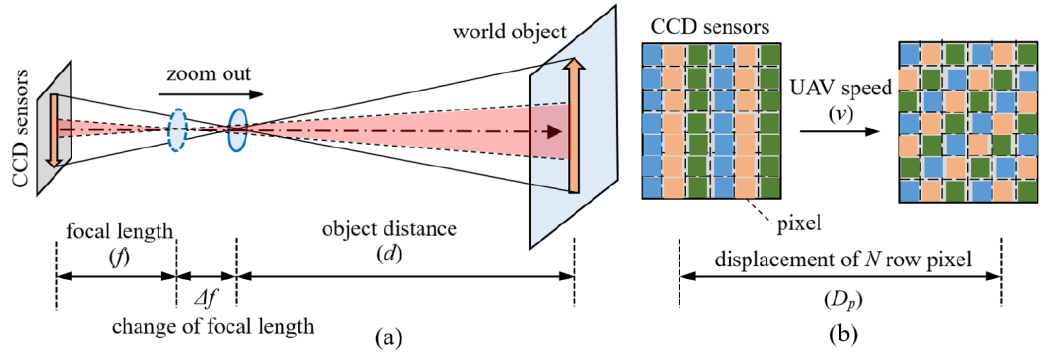
Figure 3. Zoom camera model ( a ) and motion blur principle ( b ). The degraded image g ( x , y ) caused by camera movement and noise during UAS-based imaging can be considered as the convolution of the interference-free image f ( x , y ) and the point spread function p ( x , y ) plus the environment noise n ( x , y ) , expressed as: where x and y represent the horizontal and vertical coordinates of pixels in the image coordinate system. For an image with size [M , N] , the pixel in it can be expressed as (cid:1) (cid:0) x i , y j p i , j , where 0 ≤ i ≤ M , 0 ≤ j ≤ N , and the image composed of p ij expressed as f ( x , y ). Since the speed of the UAS did not change significantly during flight and the exposure time of each frame was less than 10 ms, within this time, the displacement of the UAS was minimal. The relative displacement of the camera and the photographed bridge surface can be considered a uniform linear motion. In addition, inspection is usually conducted in good weather with enough light, so the noise caused by light and other conditions can also be ignored. Under this uniform linear motion, the exposure during image shooting can be expressed as: